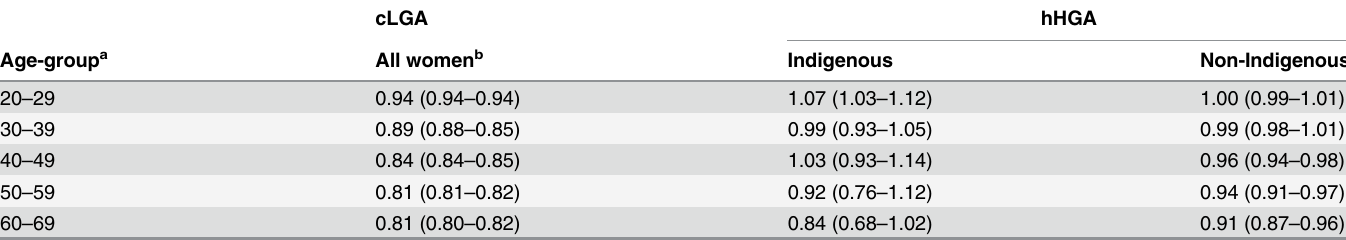
Table 4. Time trends in prevalence of cytology low-grade and histologically confirmed high-grade abnormalities by age-group, 2000 – 2011.